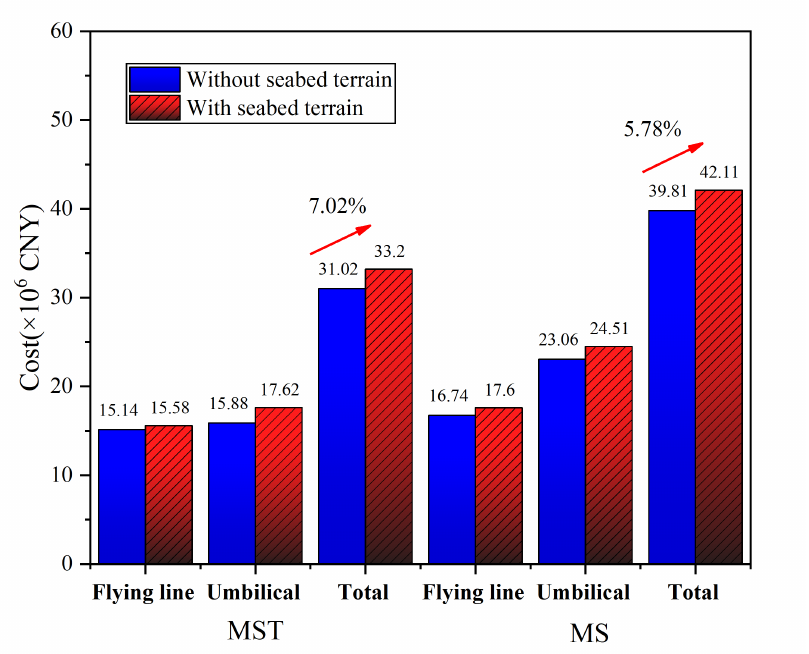
Figure 10. Comparison of the total pipeline cost with and without seabed